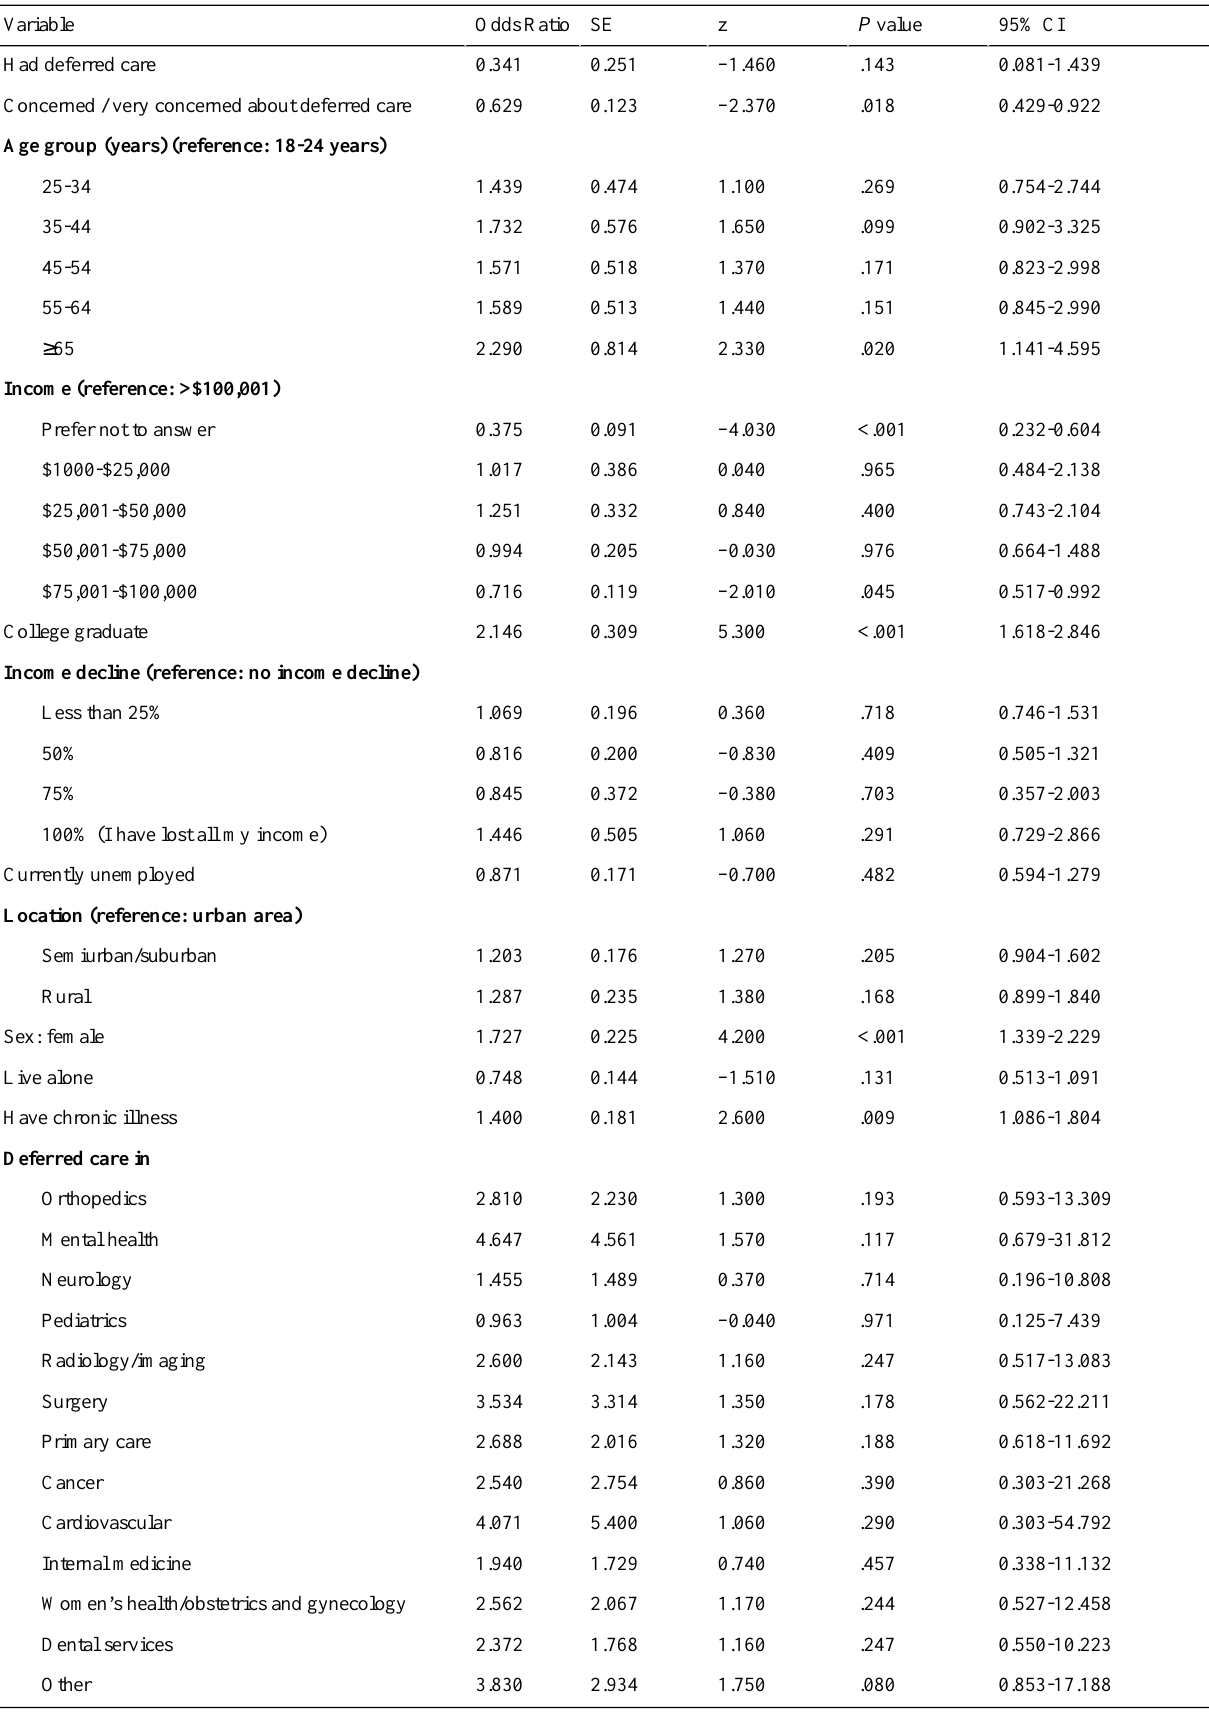
Table 6. Logit regression explaining factors predicting increased willingness to use telemedicine among 1861 survey respondents in Vermont between April 30 and May 13, 2020, with coefficients representing percentage point